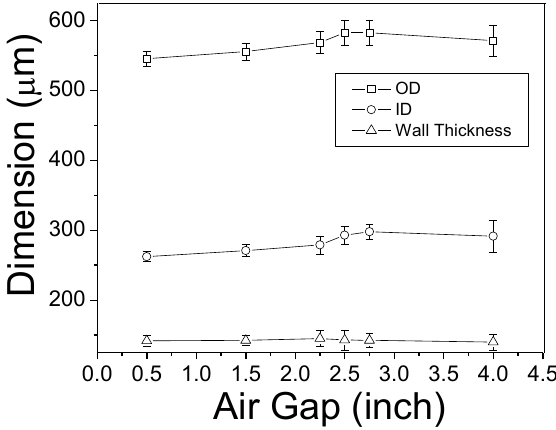
Figure 7 . PBI HF dimensional change as a function of air gap. Figure 7. PBI HF dimensional change as a function of air gap.